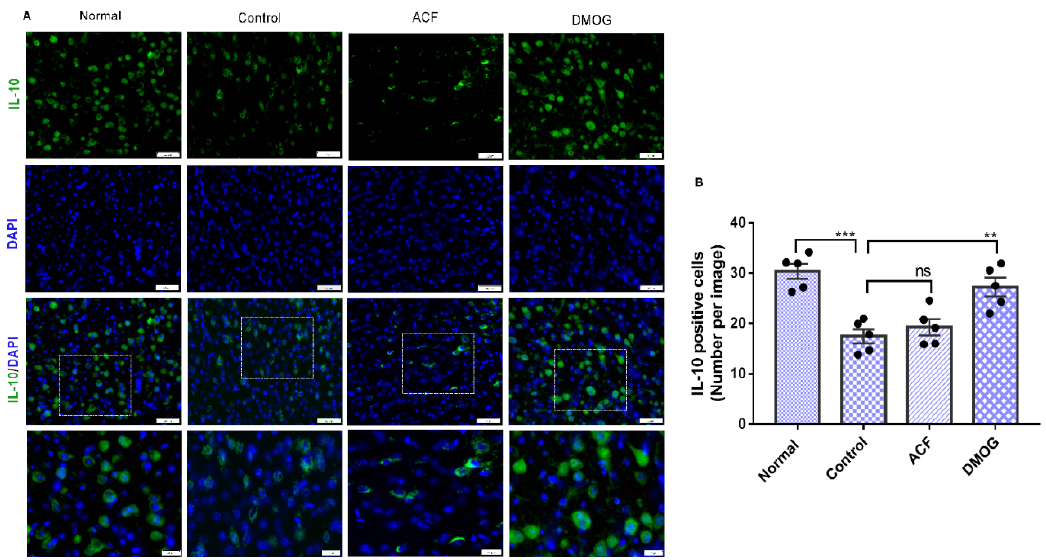
Figure 8. HIF-1 α activation attenuates inflammation via inducing the anti-inflammatory cytokine IL-10 . ( A ) Immunofluo- rescence staining of IL-10, Scale bar 50 μ m and 20 μ m ( B ) Number of IL-10 positive cells. Control vs. Normal *** p < 0.001; ACF vs. Control p = ns; DMOG vs. Control ** p < 0.01. All values are expressed as mean ± SEM, one- way ANOVA, followed by post hoc Tukey test, n = 5.